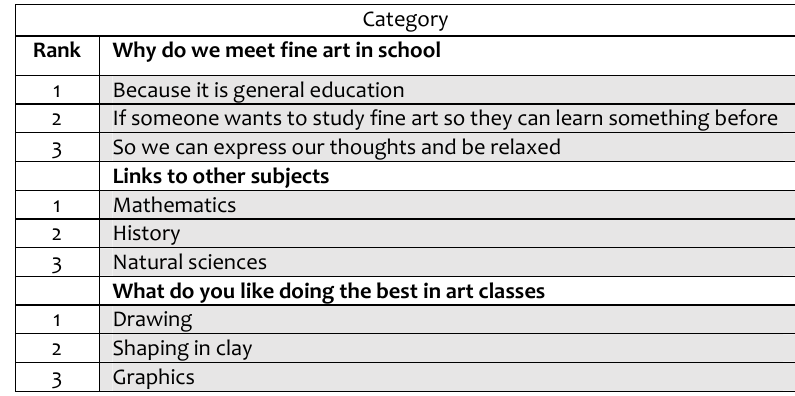
Table 2: Ranking order of the categories of answers connected with the question about fine art at